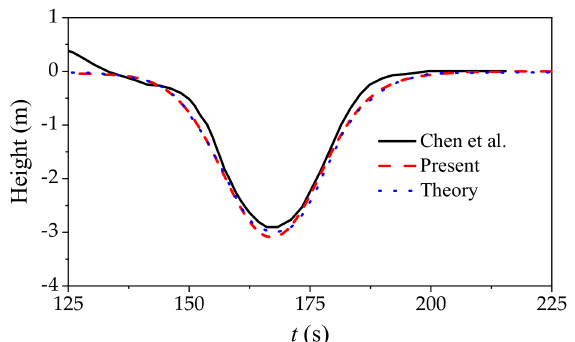
Figure 9. Comparison of the wave profiles among theory, Present and Chen’s [11]